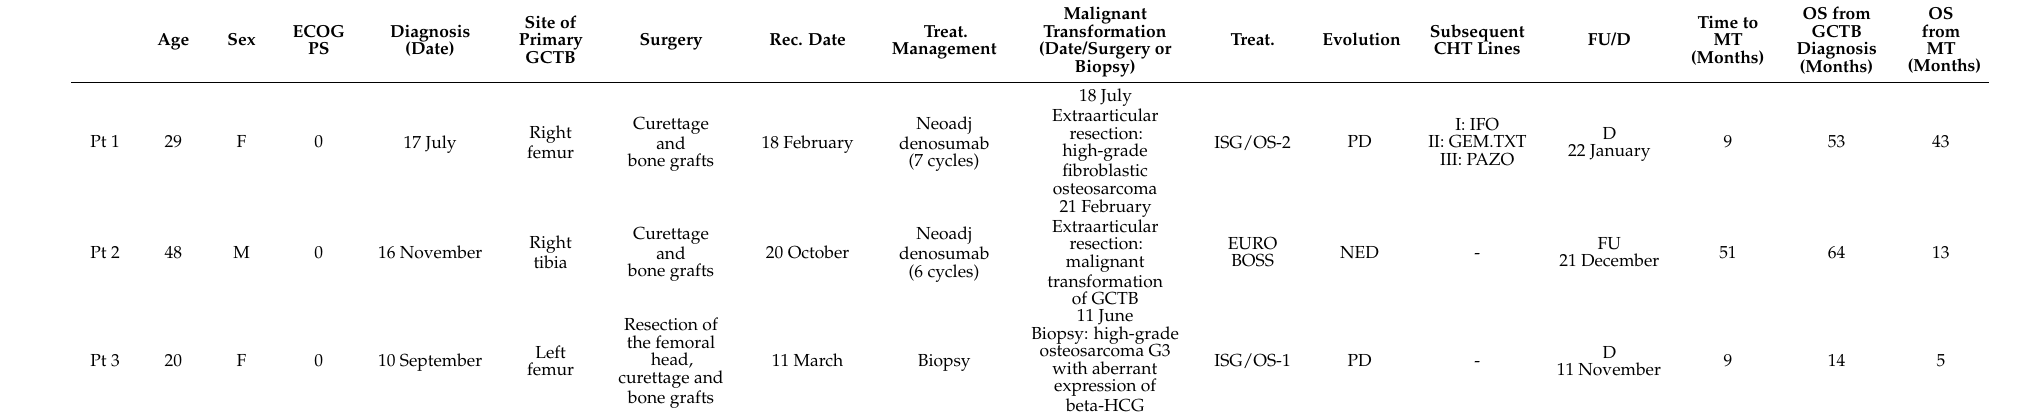
Table 3. Summary of clinical